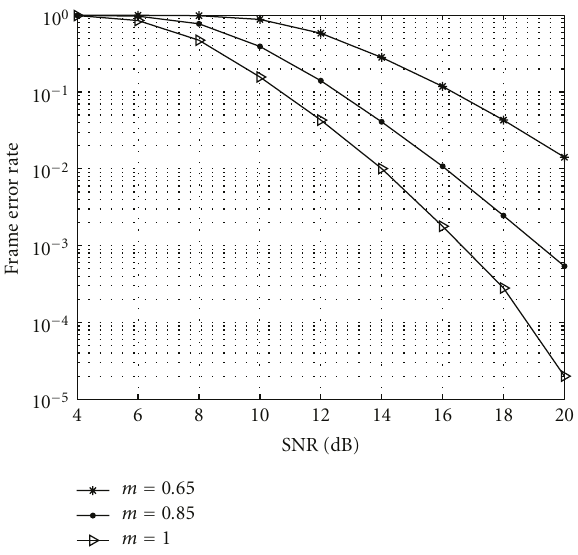
Figure 3: Frame error rate for binary PPM and binary DPPM with receive diversity order L d = 1,2, and a frame length of 128bits over AWGN channels.